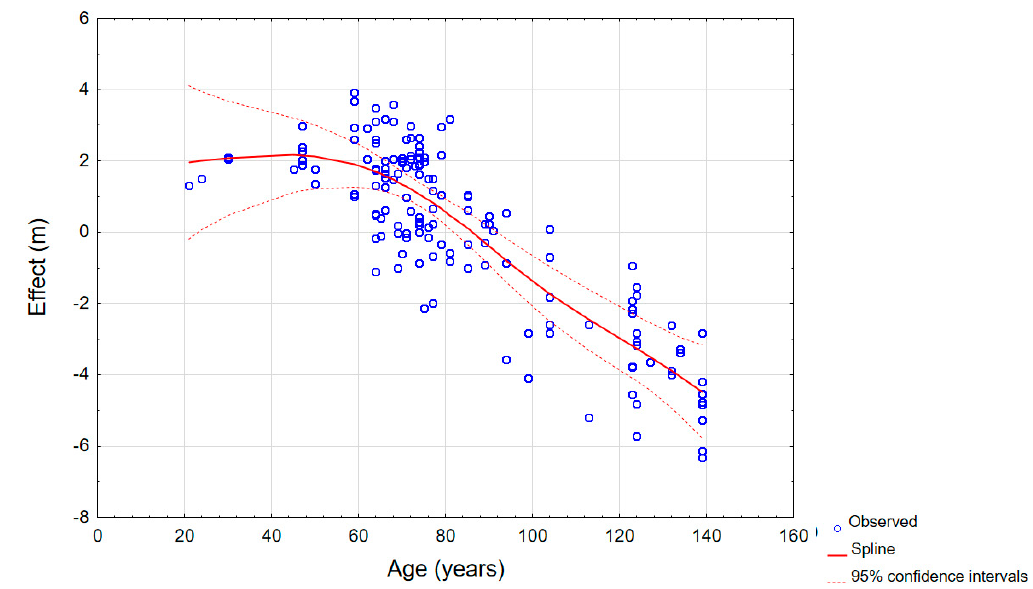
Figure 7. Partial effects of the age of the stand on the site index for oak; the effect is displayed with all other factors held constant.